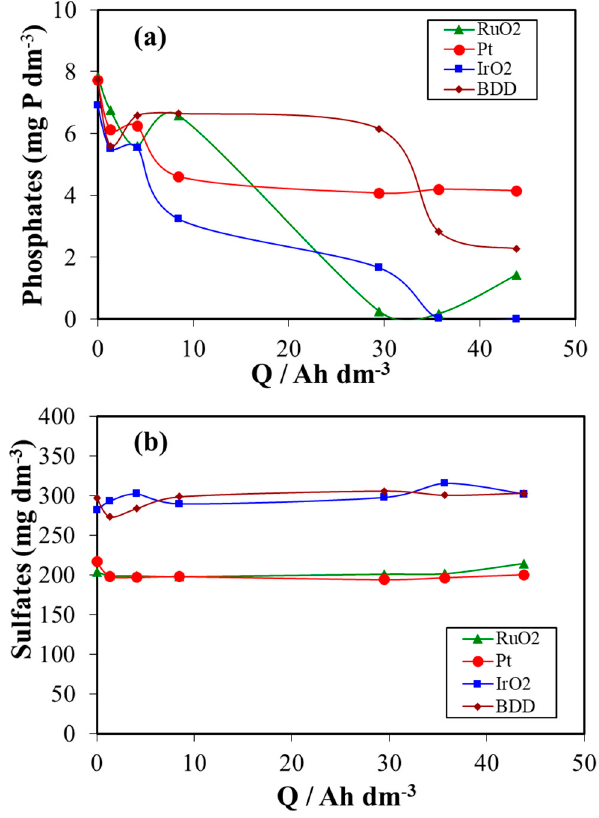
Figure 5. Changes in the concentration of ( a ) phosphates and ( b ) sulphates with the applied electric charge during the electrochemical treatment of urine wastewaters at different anode materials.